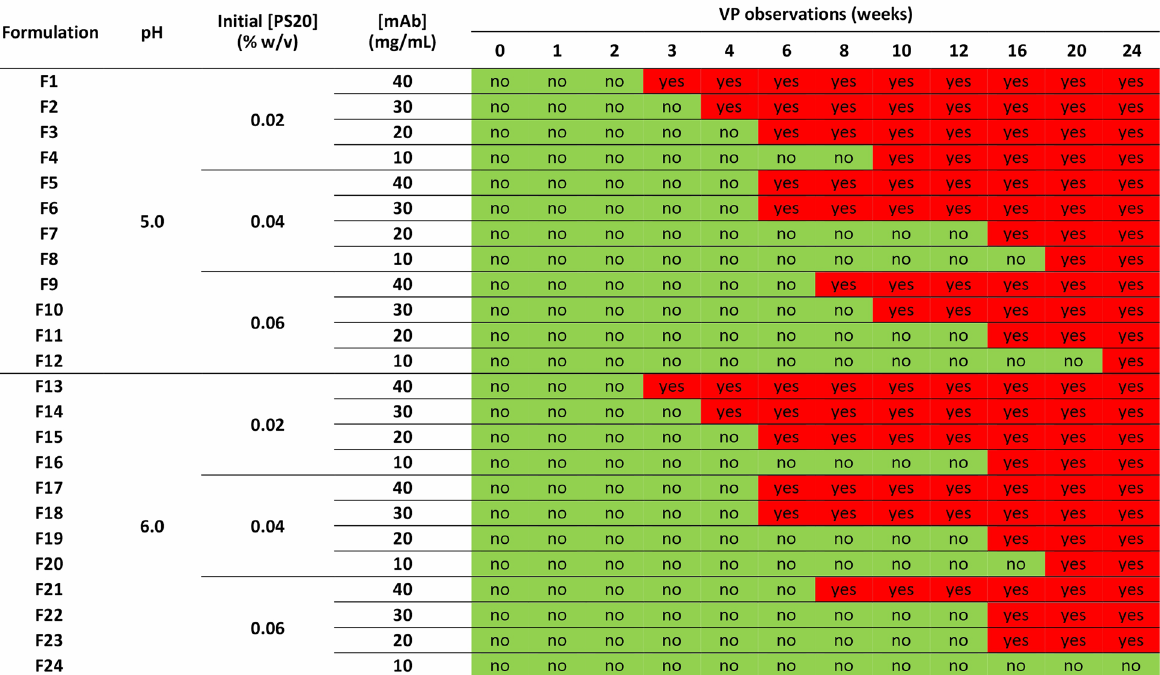
Table 1 VP observations in the longitudinal study with a full‑factorial design to assess the impact of three formulation parameters. The 24 mAb X DP formulations—differing in [mAb], initial [PS20], and pH—were stored at 5°C and monitored for VPs over 24 weeks. Three glass vials per formulation were visually inspected for VPs at each of 12 time points according to the Ph. Eur./USP